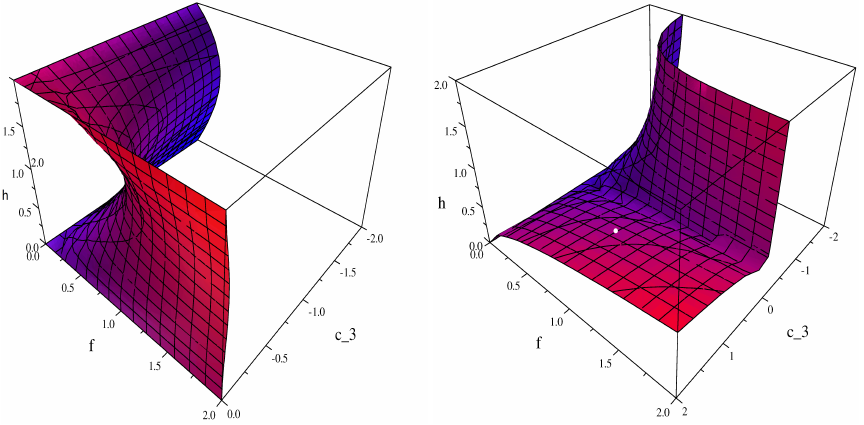
Figure 2. Borderline sets: Equation (8)—left, Equation (9)—right. White dot denotes parameters ( 1, h ∗ , 1 ) of the double critical point and corresponds to the red dot on the blue amplitude profile in Figure